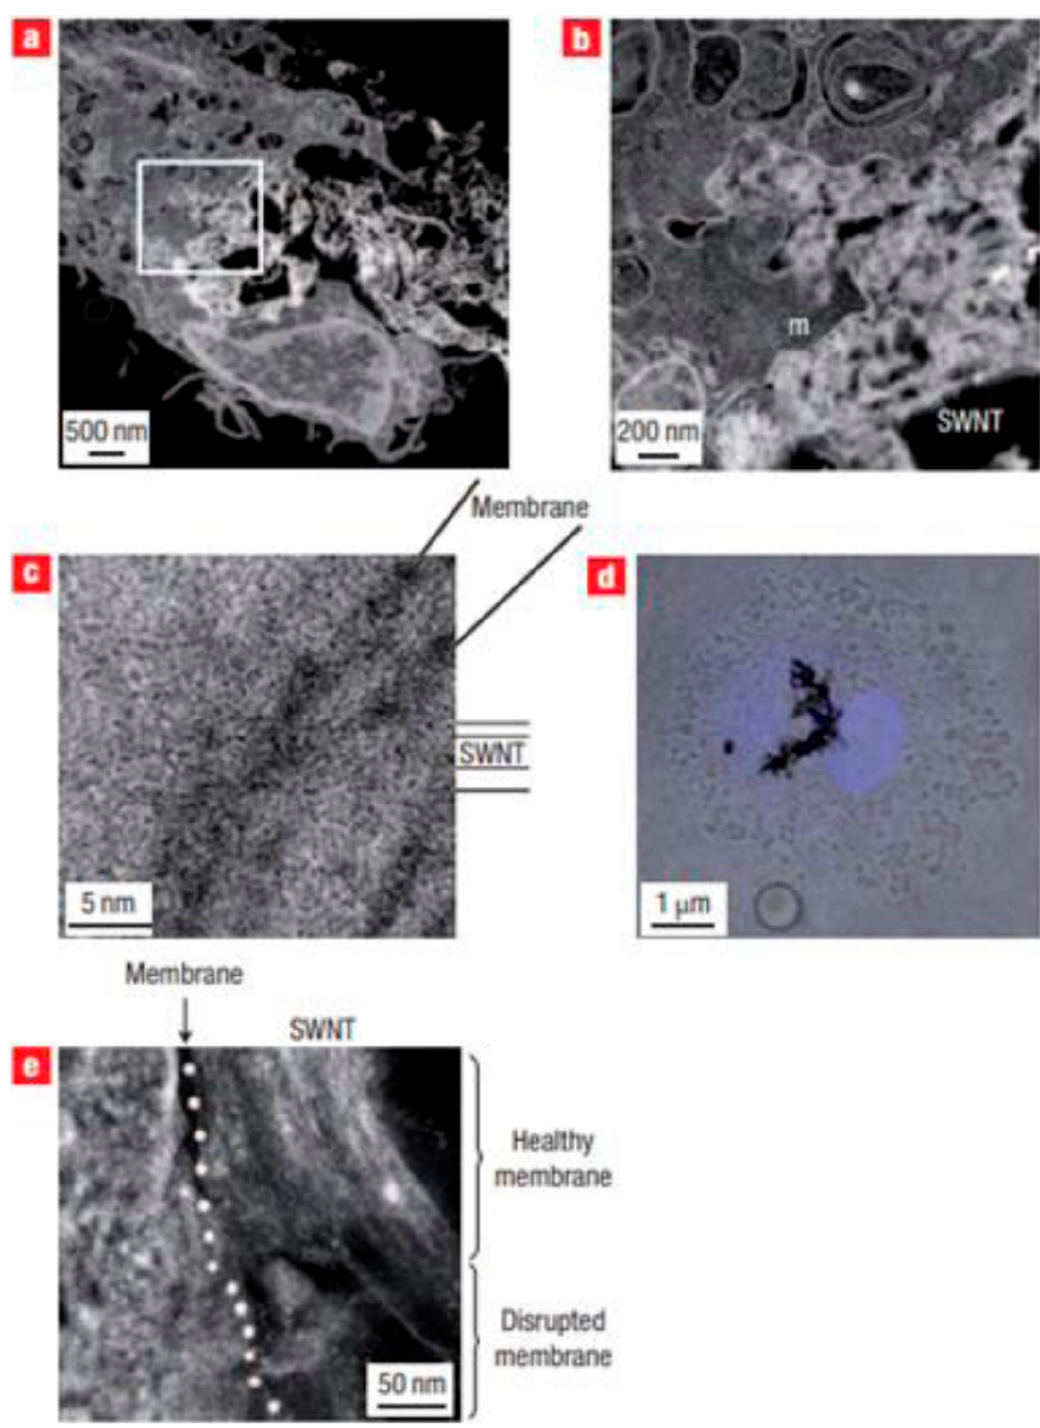
Figure 5. Localization of intracellular SWNTs within stained cell sections. ( a ) HAADF-STEM image showing SWNT bundles being actively ingested by a phagosome at 4 days. ( b ) Higher magnification image of boxed area in image a illustrating that SWNTs were compartmentalized inside the phagosomal membrane (m). ( c ) Bright-field STEM image of SWNTs translocating across the lipid bilayer into the neighbouring cytoplasm. ( d ) Confocal microscope image of HMM exposed to AgI@SWNT at 3 days, confirming inclusion of SWNT bundles inside the nucleus (blue). ( e ) HAADF-STEM image showing SWNTs within a lysosome, with membrane disruption at the region where SWNTs fused with the membrane (image reproduced with permission from reference) [39]. Copyright 2007 Springer